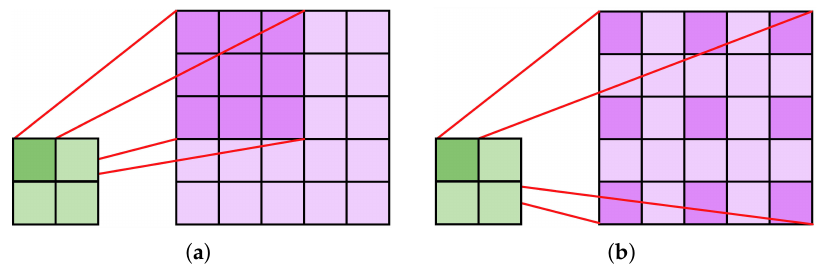
Figure 1. The ways of two different convolutions. ( a ) Naive convolution. ( b ) Dilated convolution. A hybrid dilated convolution method is proposed for HSI classification, which com- bines multi-scale residuals to obtain good classification results [54]. Although it obtains a larger receptive field through hybrid dilated convolution, there are still a lot of blind spots in the receptive field. Furthermore, traditional CNN mostly uses fixed convolution kernels to extract features, which is not friendly to multi-scale features in hyperspectral images. In order to solve the above problems, Gao et al. proposed a multi-depth